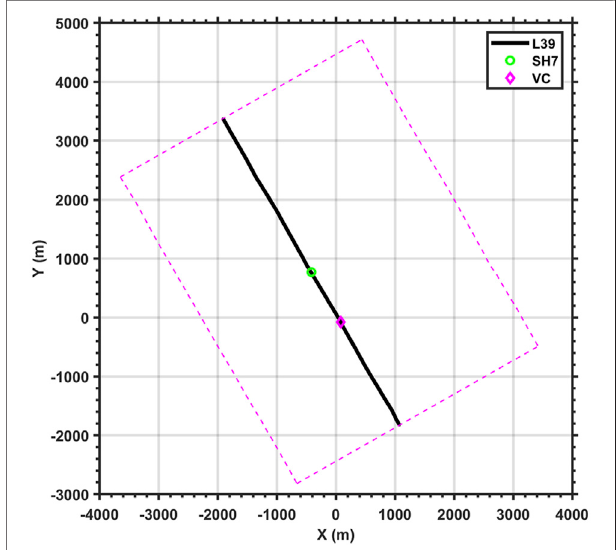
FIGURE 4 | Location of Line 39 (black line) in the 3D survey area (pink dashed frame). Blue circle shape indicates the position of Well SH7 and the pink diamond shape indicates the position of the vertical